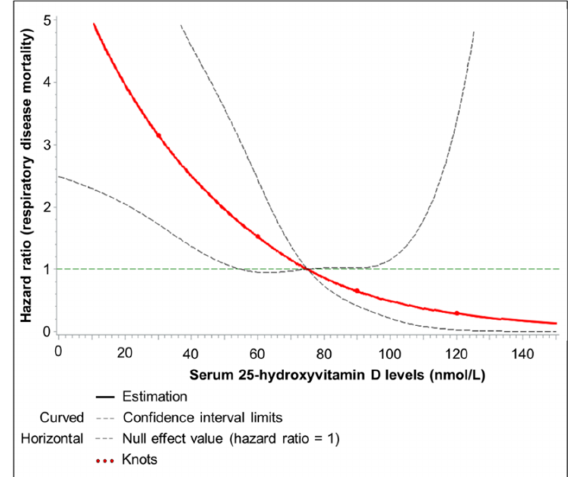
Figure 2. Kaplan-Meier curves for deaths from respiratory disease according to vitamin D status (unadjusted).